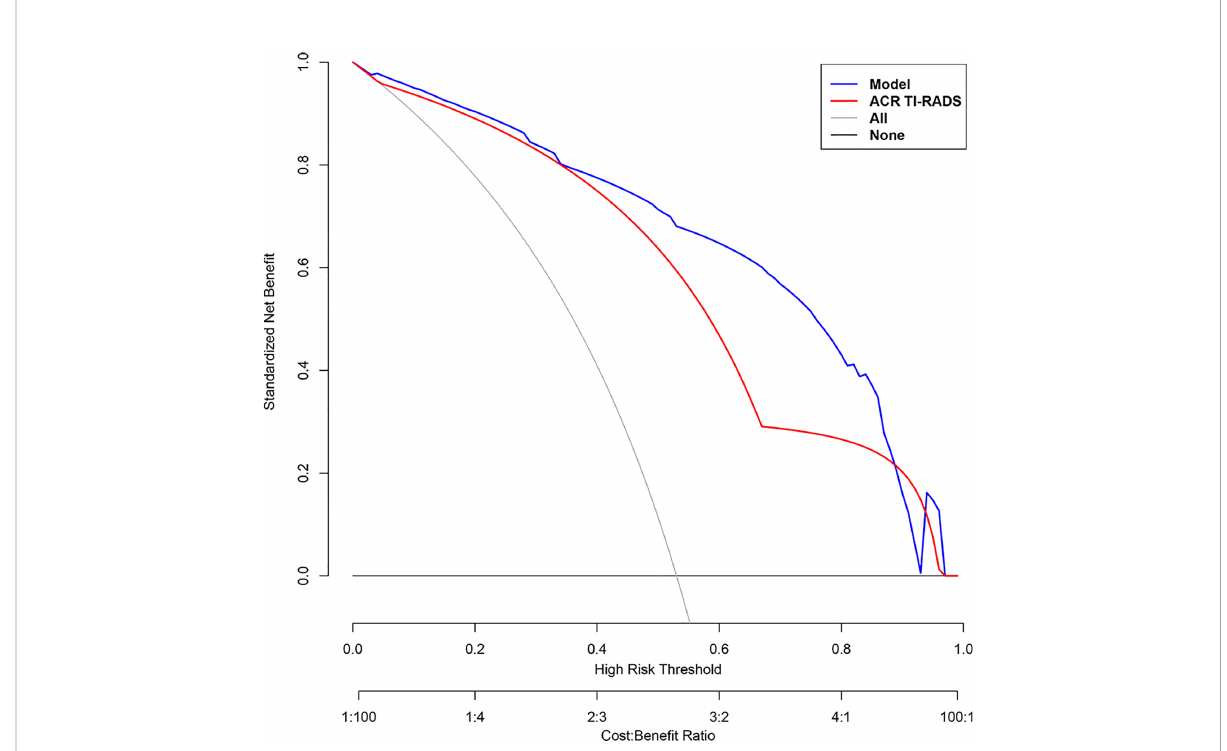
FIGURE 5 Decision curve analysis (DCA) of each model for predicting the probability of malignancy of thyroid nodules. The standardized net bene fi t is represented on the vertical axis. The horizontal axis represents the risk threshold. The gray line denotes the presumption that all lesions were cancerous. The DCA results show that the use of the multimodal ultrasonographic nomogram (blue curve) in predicting the probability of malignancy of thyroid nodules thyroid nodules provided greater bene fi t than using The American College of Radiology Thyroid Imaging, Reporting and Data System (ACR TIRADS) model (red curve) when the threshold probability was between 0 and